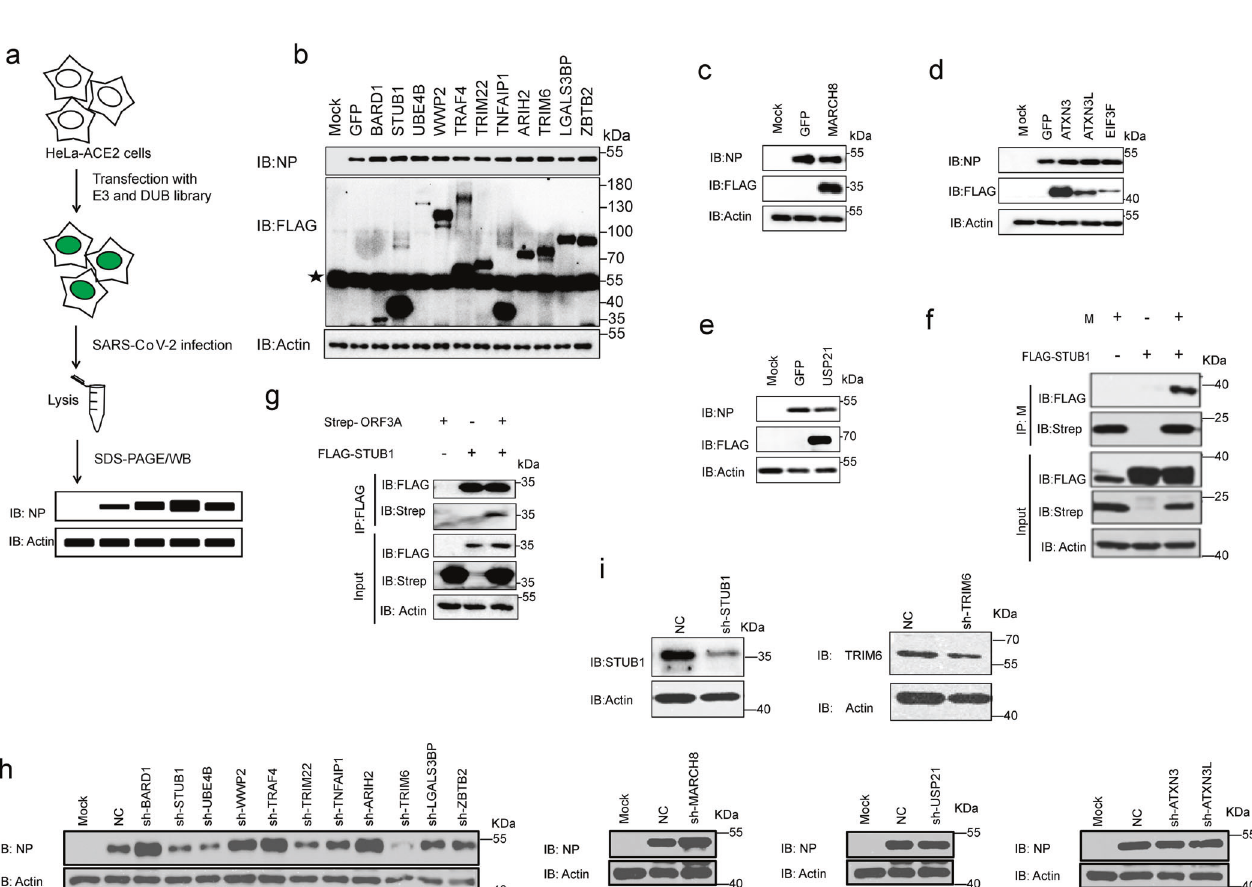
Fig. 6 Screening the E3 ligases and DUBs that affect SARS-CoV-2 infection. a The cartoon outlines the study design. HeLa-ACE2 cells were transfected with 238 E3 ligases and 39 DUBs library or GFP-vector control for 24 h, and then infected with 0.3 MOI SARS-CoV-2. Cells were harvested at 24 h after infection and lysed with 2× laemmli sample buffer and analyzed by western blotting using anti-NP. Actin was used as the loading control. b Eleven E3 ligases were identi fi ed to increase SARS-CoV-2 infection. The asterisk represents the non-speci fi c band. c E3 ligases MARCH8 was identi fi ed to suppress SARS-CoV-2 infection. d DUBS ATXN3, ATXN3L and EIF3F have been identi fi ed to promote SARS-CoV- 2 infection. e DUB USP21 was identi fi ed to suppress SARS-CoV-2 infection. f HEK-293T cells were co-transfected with M and FLAG-STUB1 expression vectors as indicated for 24 h. The cell lysates in 1% NP-40 lysis buffer were analyzed by immunoprecipitation using anti-M antibody and followed by western blotting using indicated antibodies. g HEK-293T cells were co-transfected with Strep-ORF3A and FLAG-STUB1 expression vectors as indicated for 24 h. The cell lysates in 1% NP-40 lysis buffer were analyzed by immunoprecipitation using anti-FLAG af fi nity gel and followed by western blotting using indicated antibodies. h shRNA of the 16 top hits were constructed for loss-of-function veri fi cation. Three shRNA were designed for each gene, packaged into lentiviruses. HeLa-ACE2 cells were infected with the lentiviruses for 48 h and rapamycin was used to kill those uninfected cells. These stable knockdown cells were infected with 0.3 MOI SARS-CoV-2 for 24 h and lysed with 2× laemmli sample buffer, analyzed by western blotting using anti-NP. Actin was used as the loading control. i The knock-down ef fi ciency of TRIM6 and STUB1 shRNA was analyzed by western blotting using anti-TRIM6 or anti-STUB1 antibodies. Actin was used as the loading control